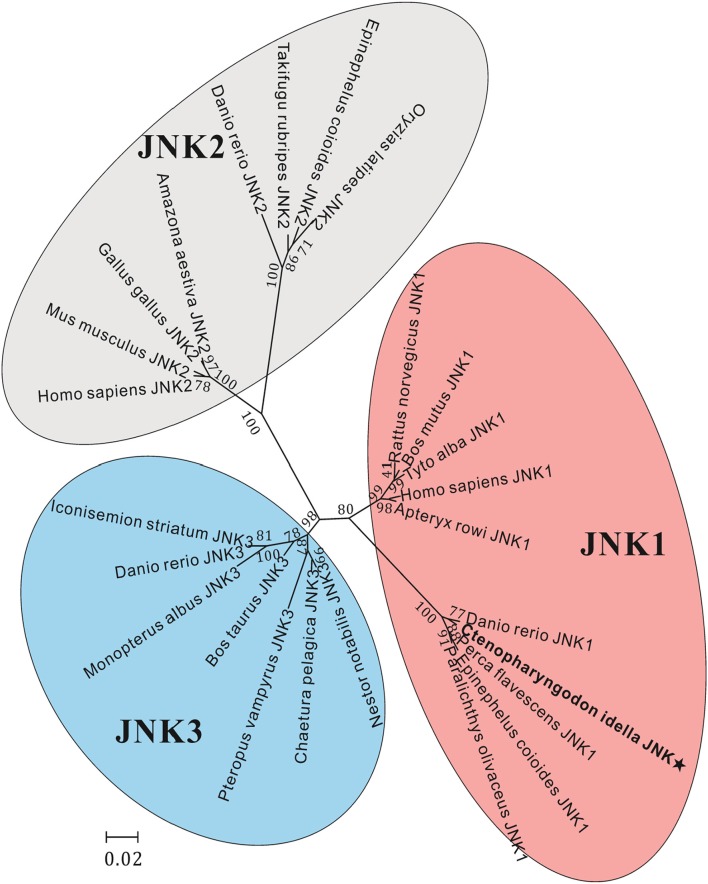
Phylogenetic analysis of JNK sequences, including JNK1, JNK2, and JNK3, was performed using the MEGA 5.05 software on the basis of the alignment of the complete amino acid sequences. The bar (0.2) represents the genetic distance. The numbers at each node refer to bootstrap values from 1,000 replications.